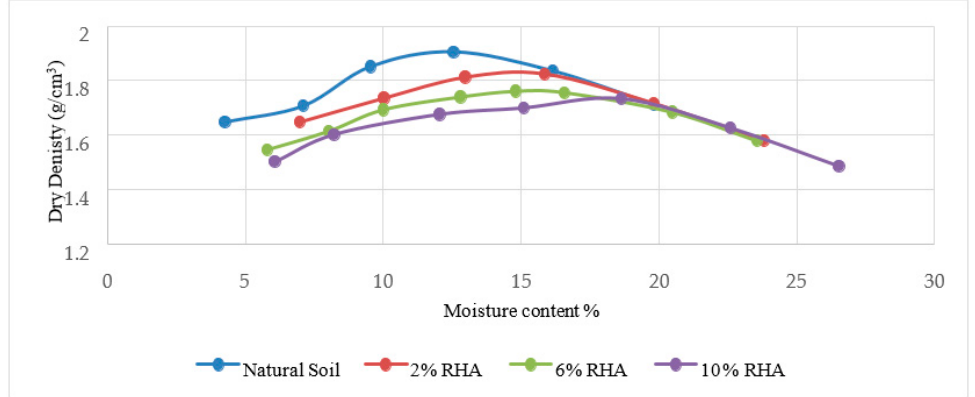
Figure 8. Rice husk ash Proctor results.